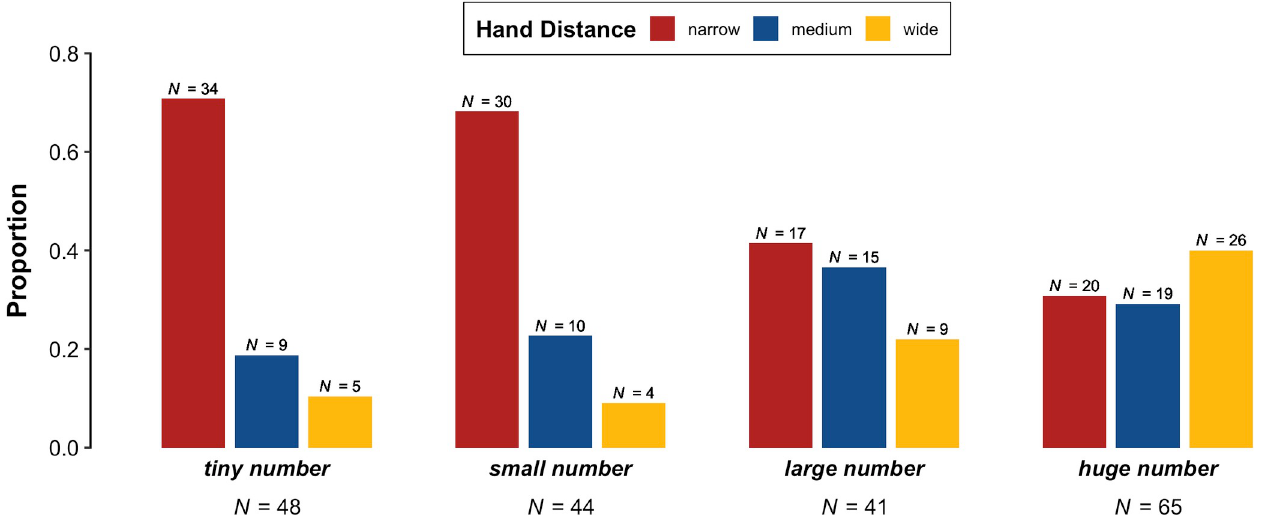
Fig 6. Proportion of two-handed gestures per phrase (’tiny number’, small number’, ’large number’, ’huge number’) in which the speaker’s hands were separated by a narrow, medium, or wide distance.